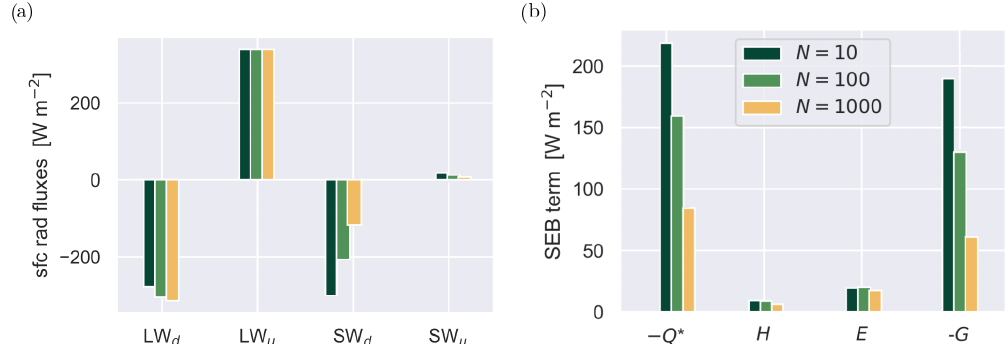
Figure 17. Same as Fig. 14 but now showing various surface (sfc) energy fluxes. (a) All four components of the net radiative energy flux Q ∗ , separated between longwave (LW) and shortwave (SW) bands as well as upward ( u ) and downward ( d ) directions. (b) All terms in the surface energy budget (SEB), including net downward radiation − Q ∗ , upward sensible heat H , upward latent heat E , and downward ground heat − G . The values are horizontally averaged over the whole surface; the time averaging then covers the last 48h of the